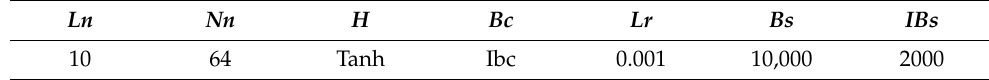
Table 2. Hyperparameters in PINN model.